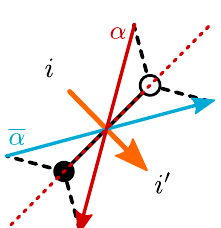
Figure 14. Crossing between a ZZP (and its image) over an edge on top of a diagonal fixed line. We show the corresponding bifundamental field in the mother